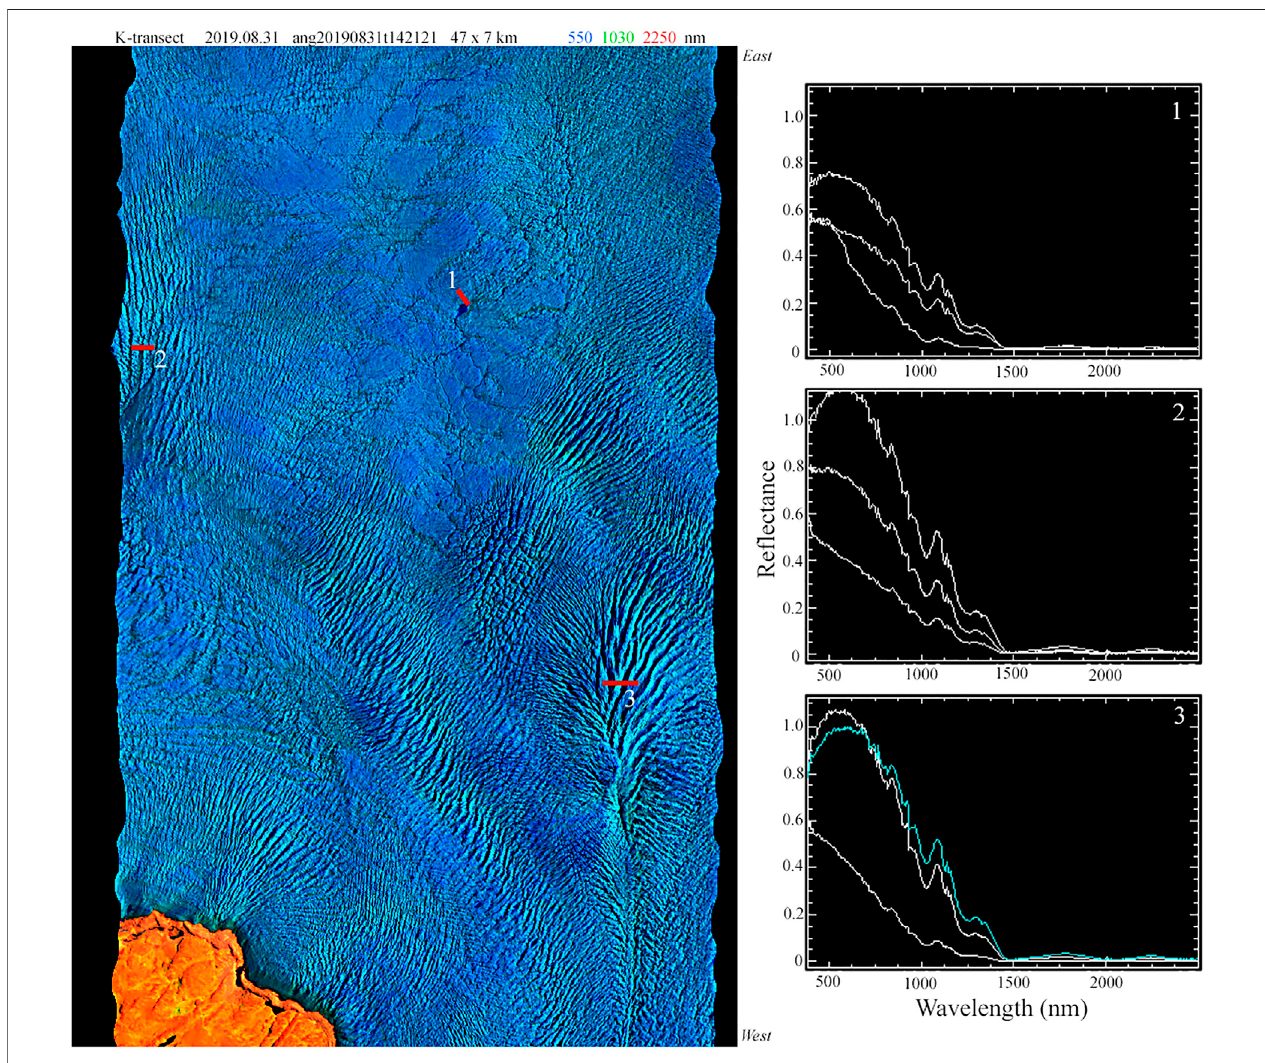
FIGURE 8 | Full resolution AVIRIS-NG swath and spectra from the western K-transect. Variations in re fl ectance and illumination geometry reveal crevasse texture andsurfaceslopeandaspect.Examplespectrafromadjacent,ornear-adjacent,pixelsshowmetertodecameterscalevariationsinicere fl ectancethatwouldcontribute to the spectral mixing occurring within decameter resolution imagery. Ground sample distance is 7.2